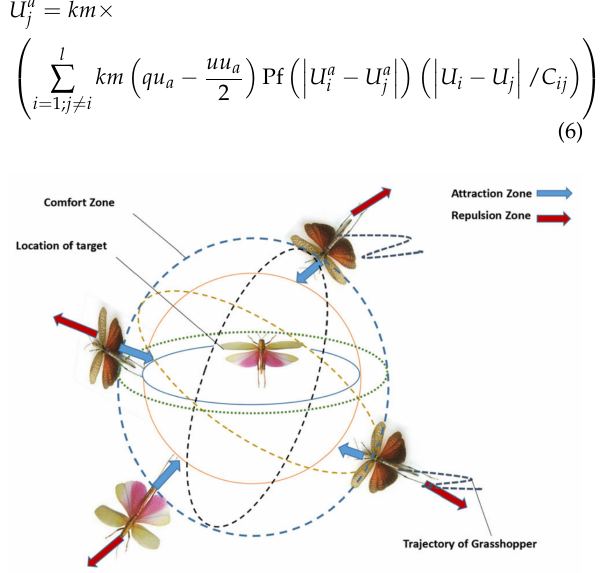
Fig. 2. A herd of locusts with a primitive correction pattern between individuals